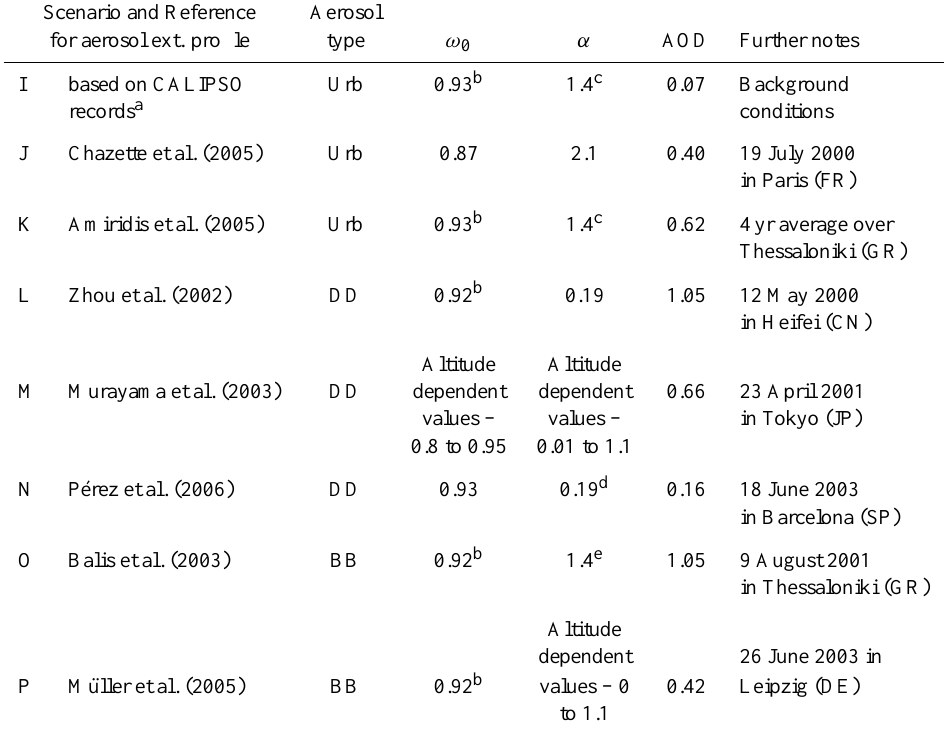
Table 2. Aerosol parameters (single scattering albedo ( ω 0 ), ˚Angstr¨om exponent ( α ) and aerosol optical depth, AOD) that were used to define the aerosol vertical profile (with extinction coefficients) for the SCIATRAN scenarios – taken from each of the references mentioned. These are representative of different aerosol types: Urban (Urb), Desert Dust (DD), and biomass burning (BB)